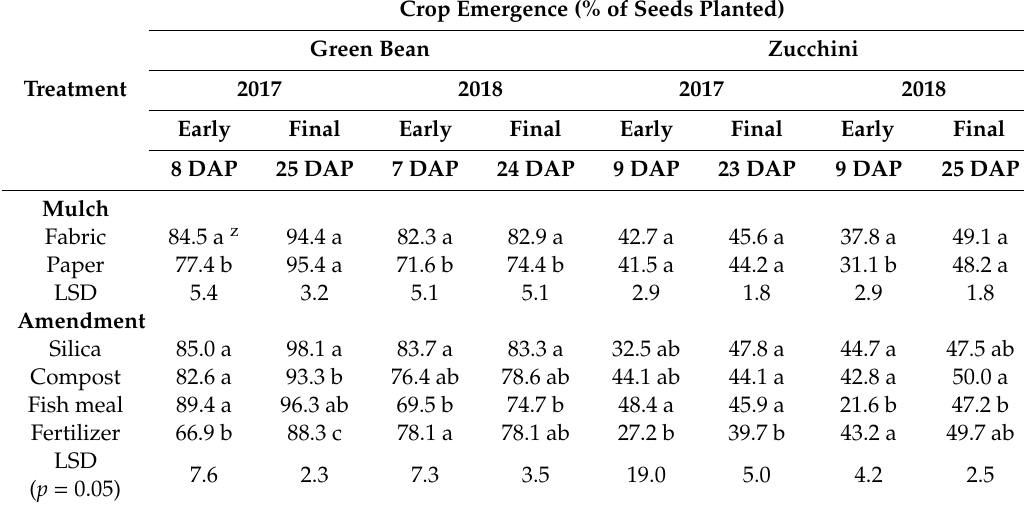
Table 5. E ff ect of mulch type and soil amendments on early and final emergence counts of green bean and zucchini squash seedlings in 2017 and 2018